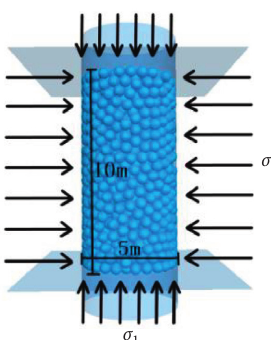
Figure 3: Schematic diagram of PFC triaxial test.